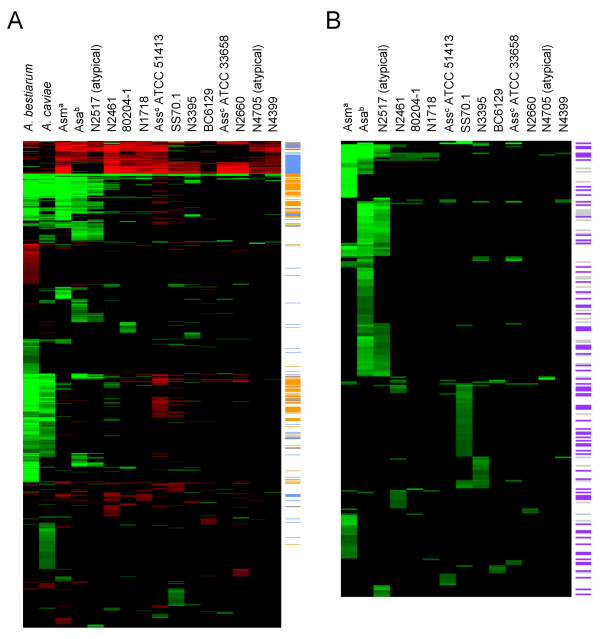
Variable genes in Aeromonas samples. Genes which were conserved (-1<Log Ratio <1) in all samples are removed. Red indicates genes with higher signal intensity for the tester than the control strain (higher copy number than strain A449). Green indicates genes with lower signal intensity for the tester than the control (divergent in sequence or missing or lower copy number). Gene order reflects results of hierarchical clustering of genes performed as described in Materials and Methods. The strains are ordered as in Figure 1, and unless otherwise noted, all other isolates are A. salmonicida subsp. salmonicida. aAsm – A. salmonicida subsp. masoucida, bAsa – A. salmonicida subsp. achromogenes, cAss – A. salmonicida subsp. salmonicida. (A) All genes which are divergent in at least one of the sixteen Aeromonas isolates. Blue bars indicate genes associated with the plasmid category and orange bars indicate genes associated with the transposon category as described in Material and Methods. (B) Subset of genes which are divergent (Log Ratio< -1) in the fourteen A. salmonicida strains and were not assigned to the plasmid or transposon functional categories. Genes predicted to code for OMPs (purple) and for flagella/pili proteins (grey) are indicated.